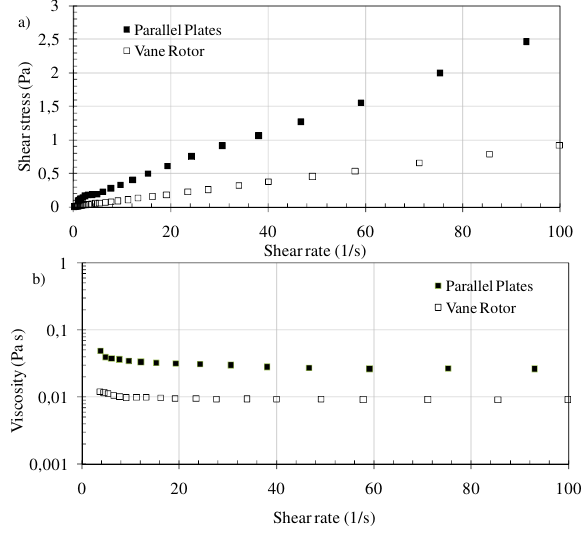
Fig. 4. Liquid paraffin on sale. Comparison of parallel plates results and vane rotor results.